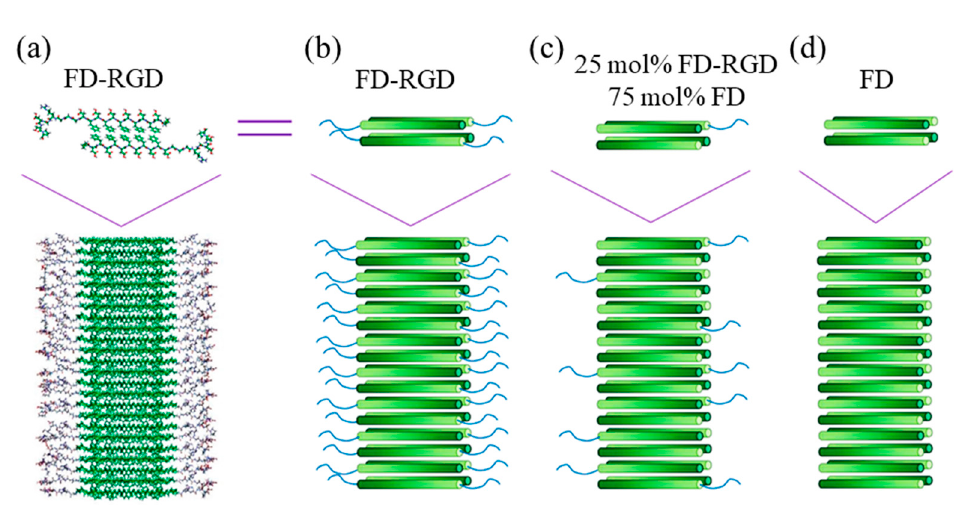
Figure 6. ( a ) Scheme showing a molecular model of Pro-D FDFDFDFDFD GGGRGDS-Pro (FD-RGD) assemblies) and ( b – d ) cylinder representations with a gradient color from the N- to C-termini (dark to bright, respectively). The β -strand conformation positions the hydrophobic Phe side chains from both layers facing each other, while the hydrophilic side chains point to the surrounding aqueous phase. The top schemes show four peptides arranged in a bilayer that constitutes the fibril shown in the bottom scheme. Reproduced from [120].